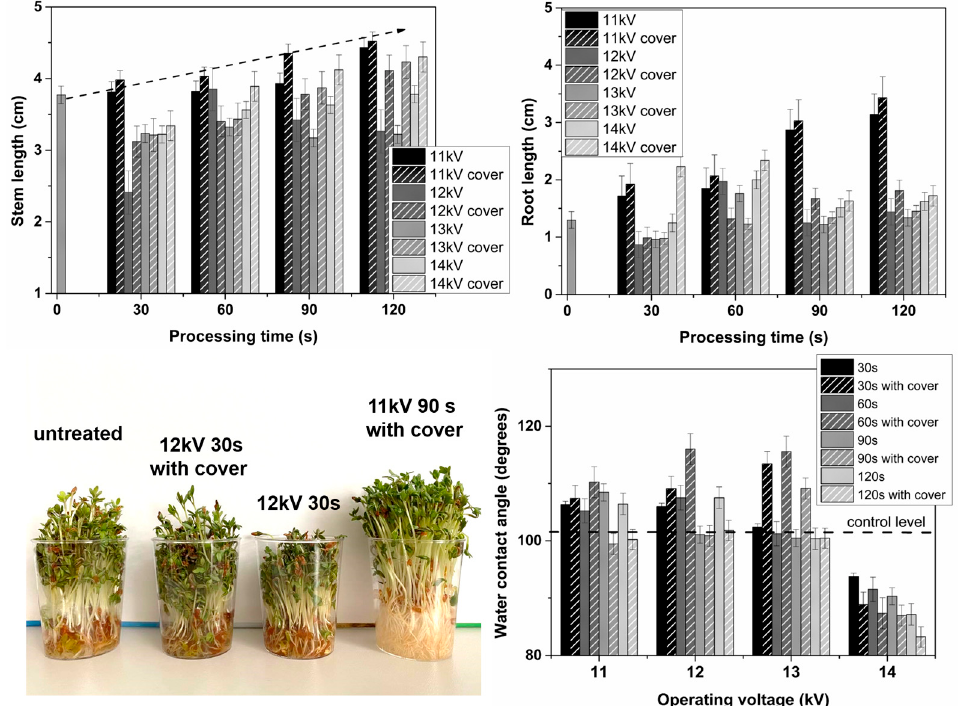
Figure 7. Biometric measurements for cress sprouts (stem and root length) and water contact angle for the seeds after treatment in different conditions.